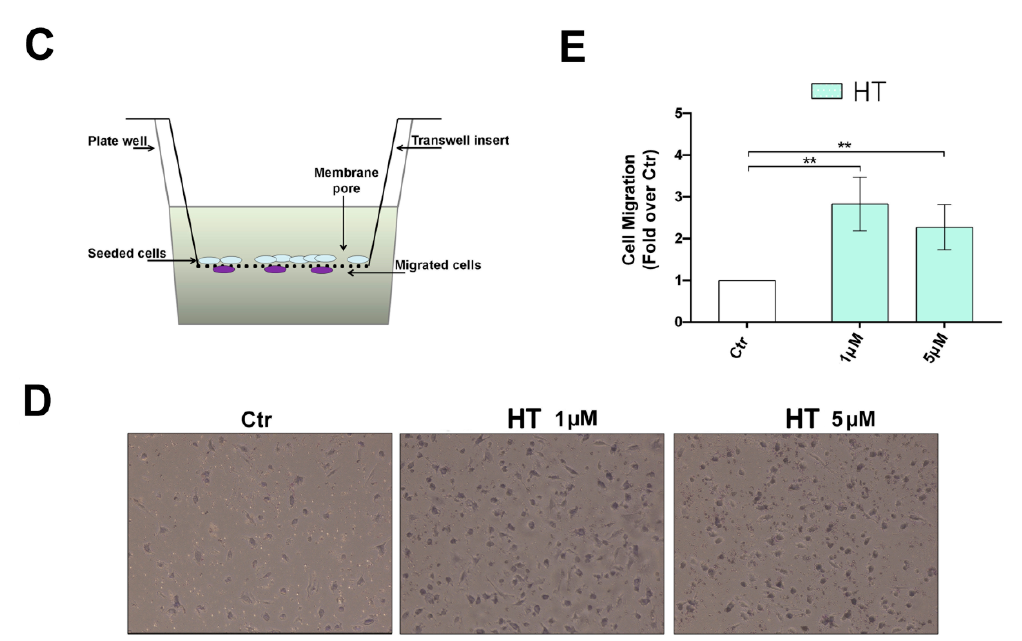
Figure 2. Improvement of the migratory capacity of HUVEC cells exposed to HT. ( A ) Wound healing assay were carried out in HUVECs treated for 6 h with HT at the indicated concentrations (1–5 µM) in complete medium. Light microscope images are representative of three independent experiments. Dotted white lines indicate the wounded area from the initial scratch. Magnification × 100; ( B ) Histograms correspond to the mean scratch area obtained in HUVEC cultures, and are expressed as a percentage with respect to the initial area. The measurement was carried out in three different experiments. Results are shown as mean (± SD) (2-way ANOVA, * p < 0.05). ( C ) Cell migration was determined in the Boyden chamber system after seeding HUVECs in the upper insert and treatment with HT. ( D ) Cells that migrated beneath the membrane were fixed and stained and representative light microscope images of three independent experiments are shown (10 × magnification). ( E ) The effects of HT on cell migration, at the indicated concentrations, were observed after overnight incubation. Results, reported as folds over the control, are shown as mean (± SD) (2-way ANOVA, ** p < 0.01).